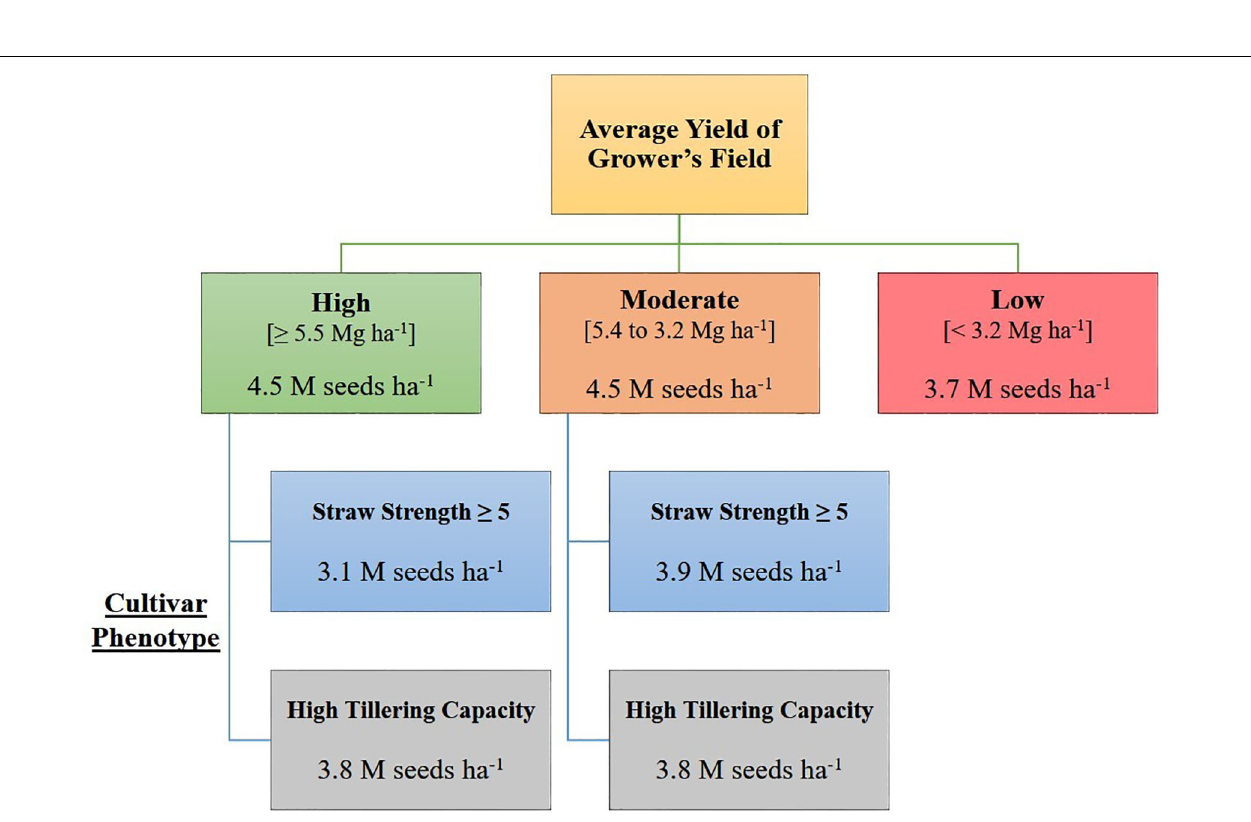
FIGURE 3 | Decision support system (DSS) for growers to determine optimal seeding rates for HRSW cultivars sown in diverse yielding environments in ND and MN. Based on decision tree model in R from analysis of seeding rate dataset ( n = 351).